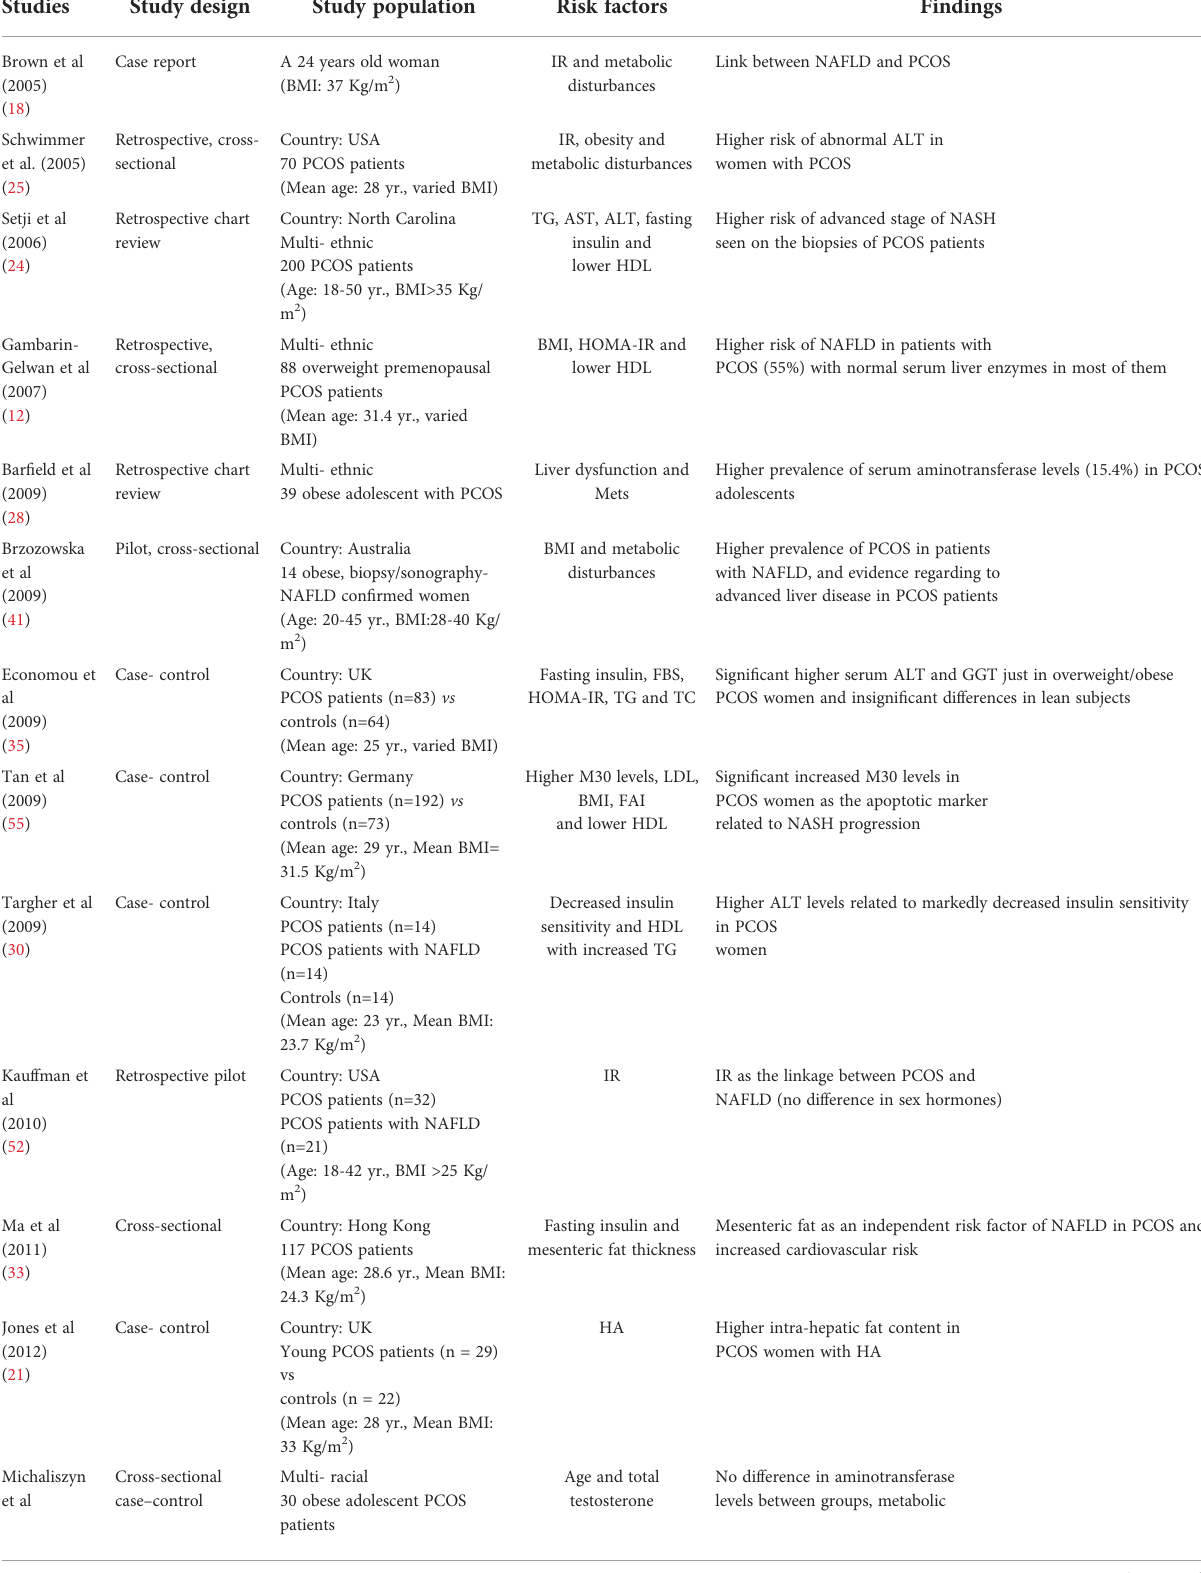
TABLE 1 Studies investigating the risk factors for the development of NAFLD in PCOS